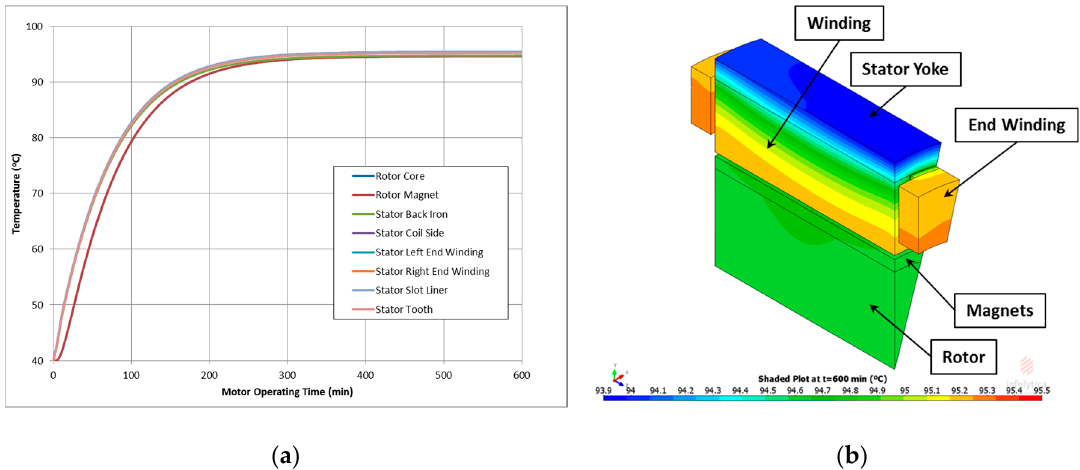
Figure 16. Motor Thermal Analysis Results: ( a ) Time-based Temperature Profiles for Various Motor Components; ( b ) Temperature Contours for 3D Thermal Modeling at 600 min.